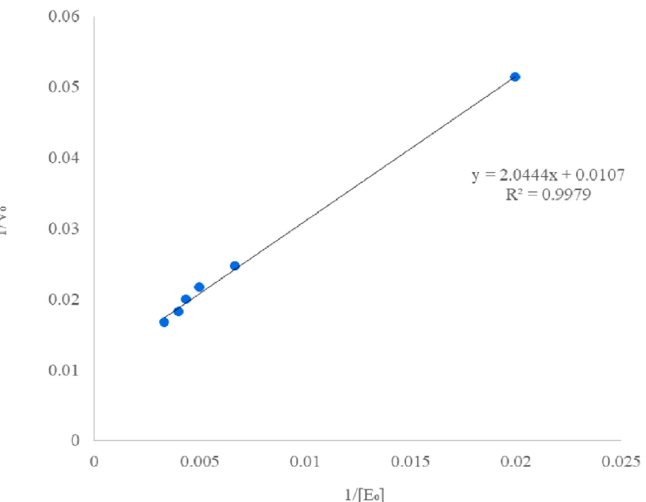
Figure 5. Effect of initial enzyme concentration on pre-treated PALF initial hydrolysis rate (NaOH pre-treatment conditions: 2.43% ( w/v ) NaOH, the temperature of 87.22 °C, and the hydrolysis time of 57.15 min). Experimental values were plotted based on Equation